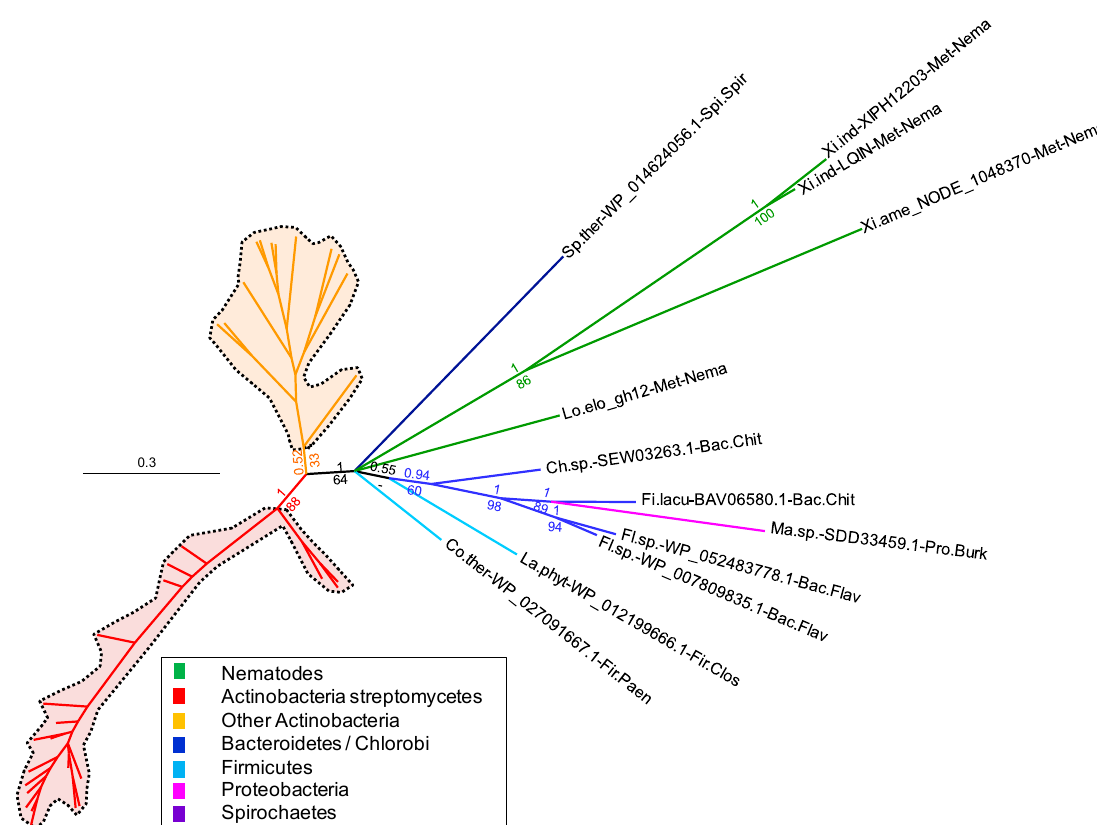
Figure 2. Phylogenetic tree of X. index , X. americanum , and L. elongatus GH12 protein and homologs. The Bayesian topology has been chosen as a reference and posterior probability support values are indicated at corresponding branches. The corresponding bootstrap support values from the Maximum Likelihood analysis are indicated below probability values. Abbreviated species names (prefix), accession number and taxonomic classification (suffix) are indicated in leaves. Full names are listed in Supplementary Table S8. The corresponding expanded phylogenetic tree is available as Supplementary Figure S2.